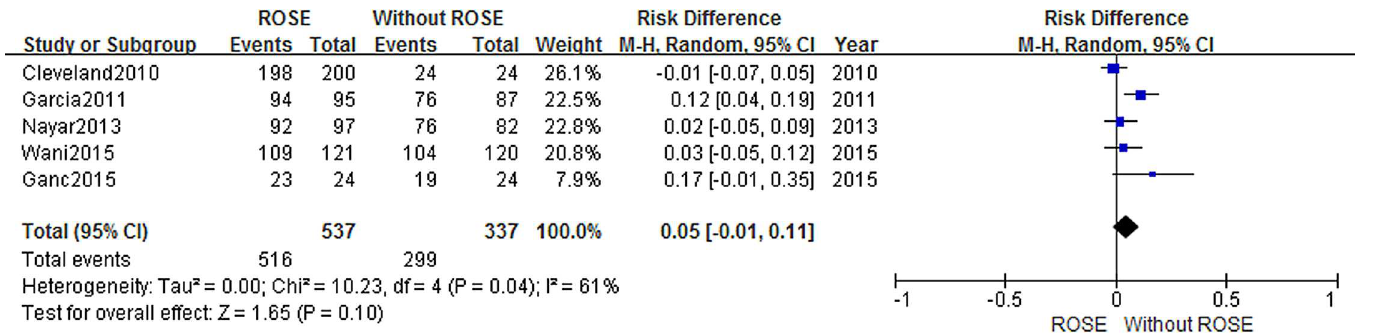
Fig 2. Forest plot displaying the Risk Difference and 95% CIs of each study for the adequacy